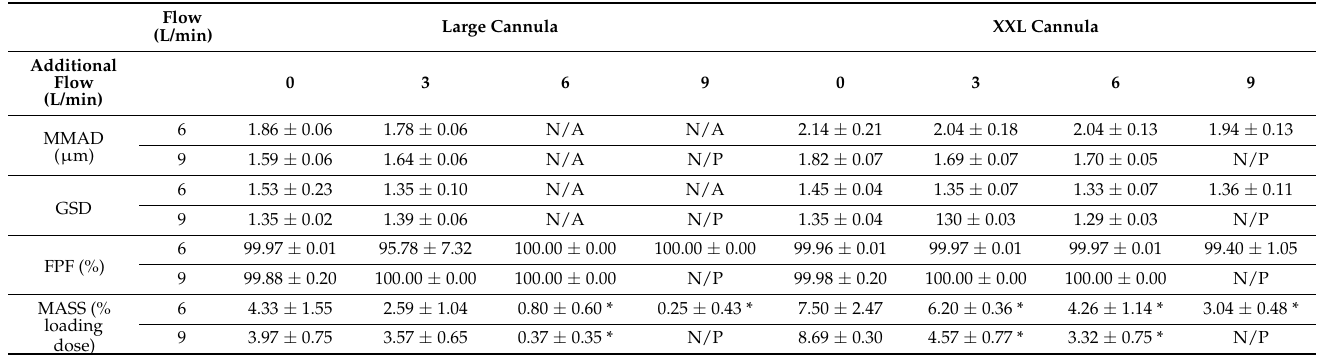
Table 2. Outcome measures with the nebulizer operated at 6 and 9 L/min with additional flow from the heated flow nasal cannula